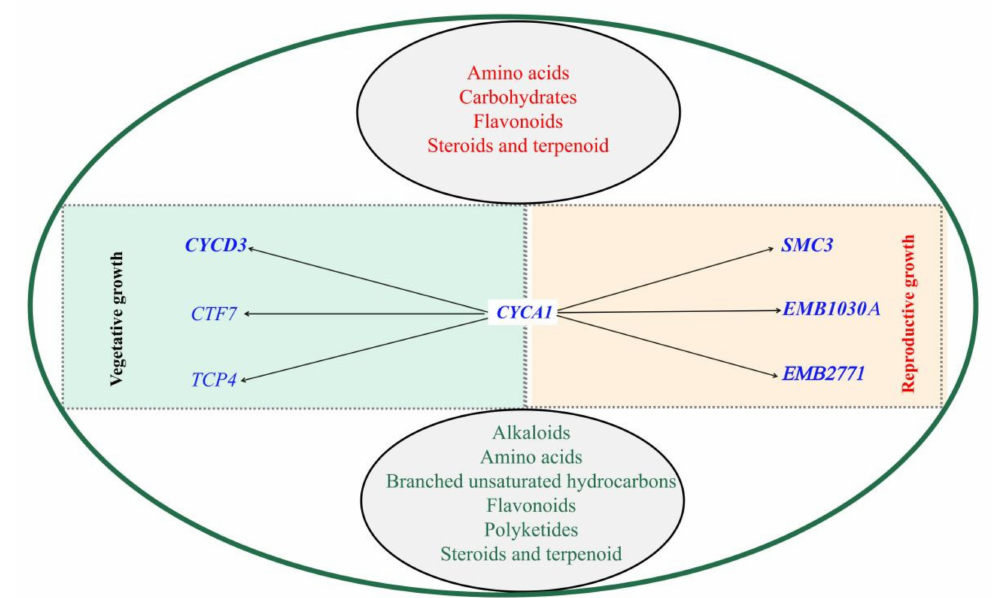
Figure 7. The GMS genetic network caused by VrCYCA1 , related-genes and metabolites in mungbean. Bold genes represent significantly differentially expressed genes. CYCD3 , TCP4 and CTF7 participate in vegetative growth, and SMC3 , EMB1030A and EMB2771 participate in reproductive growth. The red and green fonts represent the four categories of significantly downregulated metabolites and six categories of significantly upregulated metabolites,